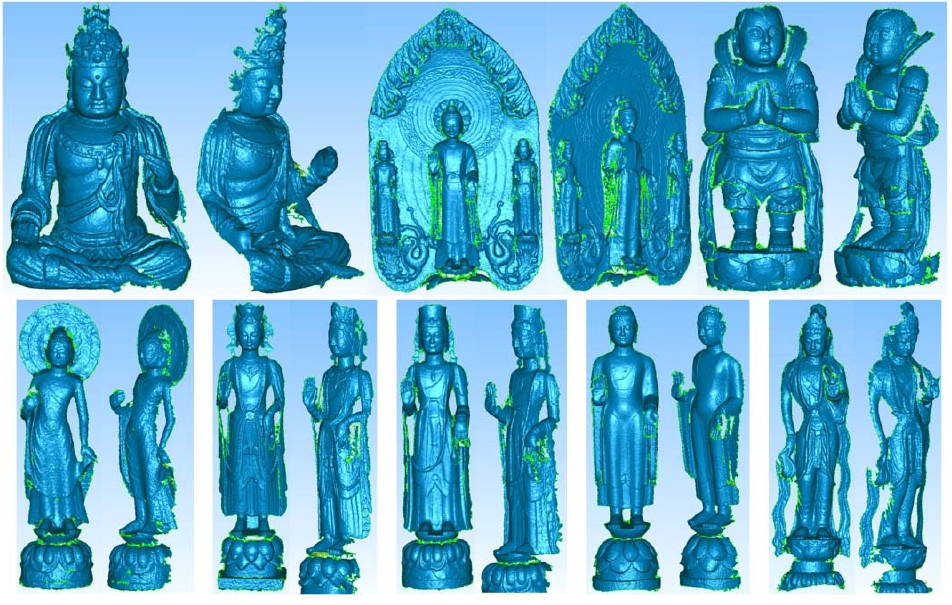
Figure 17. Eight Buddhist statue models generated by the proposed